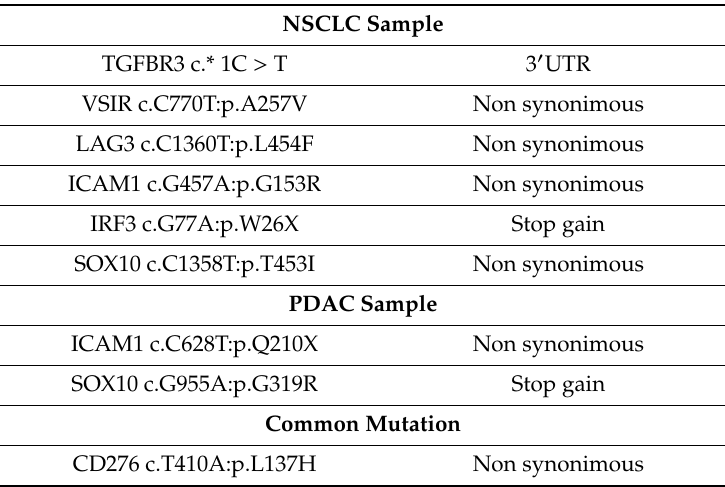
Table 1. Alterationsdetected through custom targeted panel innon-small cell metastatic lung cancer (NSCLC) and pancreatic ductal adenocarcinoma (PDAC)